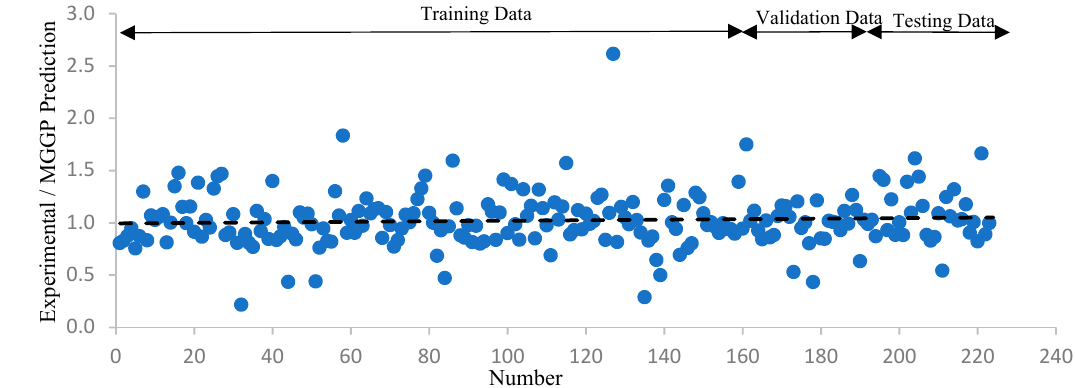
Figure 8. Experimental to MGGP-predicted bond strength rations.